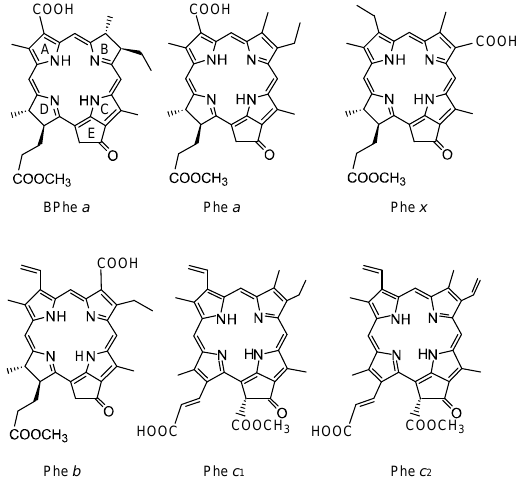
Figure 31. Chemical structure of Phe sensitizers, including BPhe a having the bacteriochlorin skeleton, Phe a , Phe x and Phe b having the chlorin skeleton, and Phe c having the porphyrin skeleton. and Phe c 2